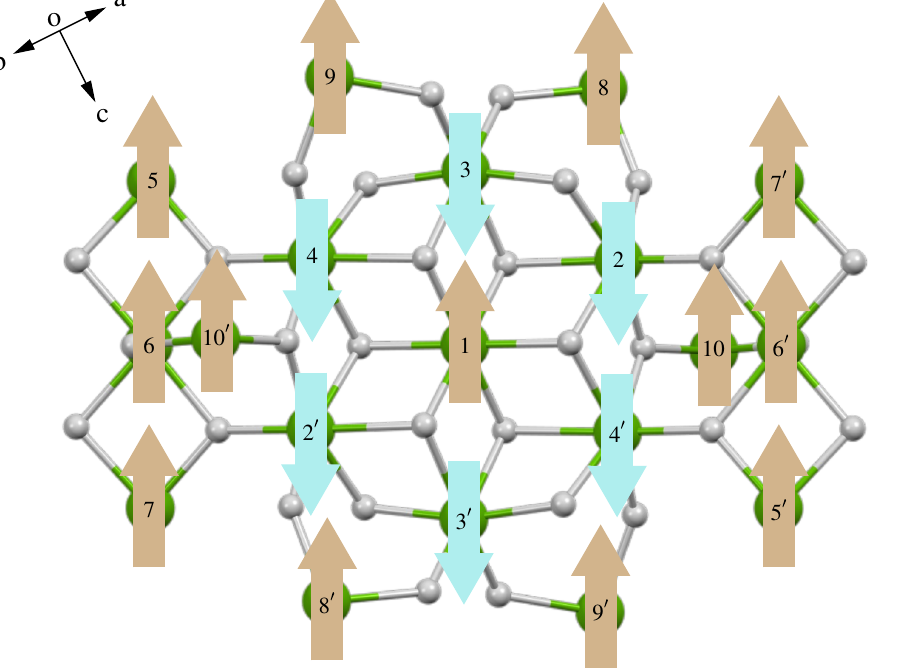
Figure 1. The core of the Fe 19 molecule viewed along the (110) crystal axis, showing only the Fe atoms and the bridging O atoms. The site labels for the Fe atoms are shown, and site 1 is a centre of inversion. The S = 35/2 ground state of the molecule is the result of strong intramolecular exchange interactions that place the six Fe sites surrounding the central Fe on one spin sublattice with the remaining thirteen Fe sites, including the central site on a second sublattice with opposite spin. The easy axis is shown as vertical in this figure for clarity, the direction previously suggested by EPR [13] is a vector from site 1 to site 2, whereas, in this study, we found a direction closer to the site 1 to site 10